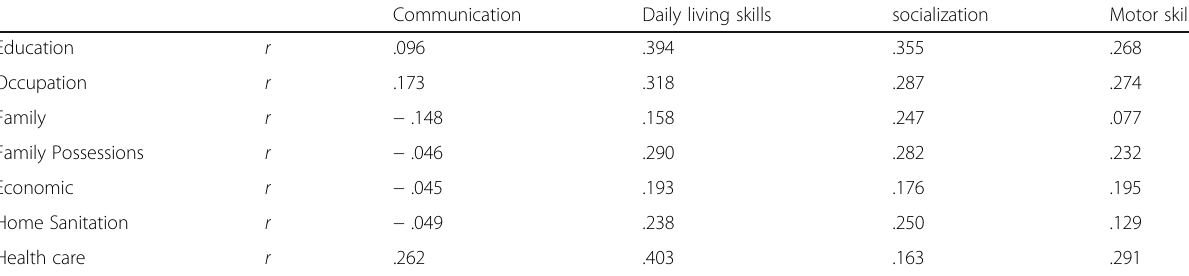
Table 3 Correlation between adaptive functioning and domains of socioeconomic status of studied children